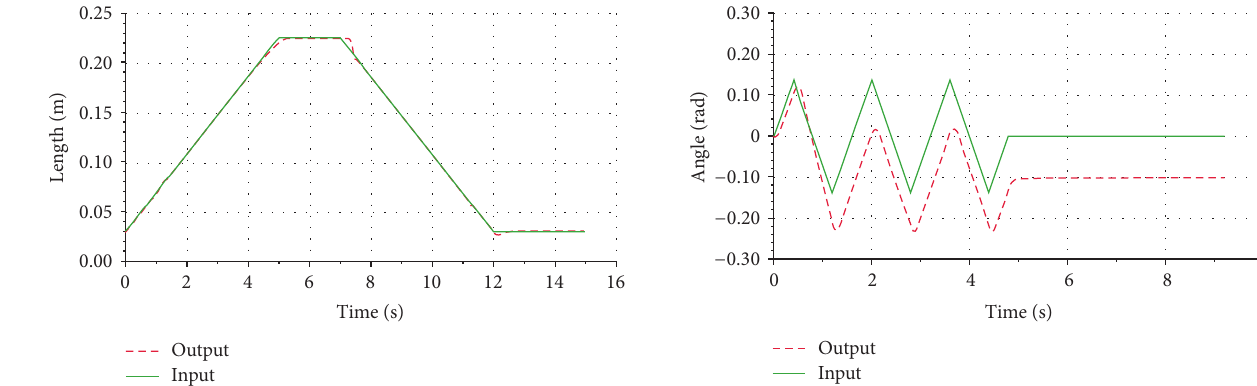
Figure 15: The relationship curve of the hand wheel steering system input and output changing with time.